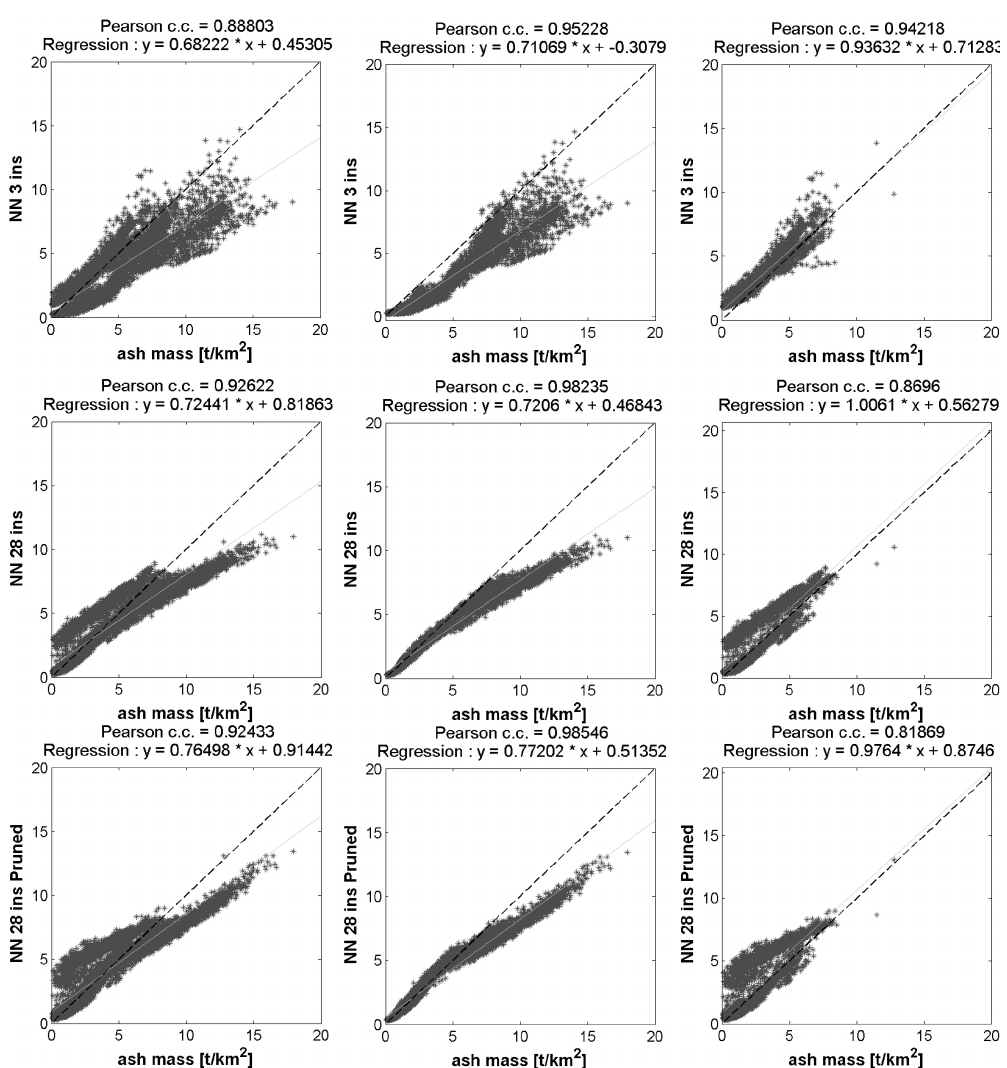
Figure 6. Scatterplots for ash mass networks, 3 inputs (top row), 28 inputs (middle row) and 28 inputs pruned (bottom) row, applied to the validation set of 12 May 2010, 12:55UTC, divided into total patterns (left column), patterns over sea (middle column) and patterns over meteorological clouds (right column).